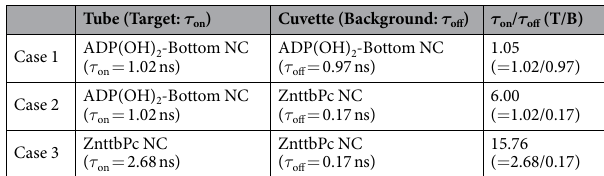
Table 1. NC: Nanocapsules. In Case 1, both the tube and the cuvette were filled with ADP(OH) 2 -Bottom encapsulated 5%-F98 pluronic nanocapsules. In Case 2, the tube was filled with ADP(OH) 2 -Bottom encapsulated 5%-F98 pluronic nanocapsules and the cuvette with ZnttbPc encapsulated 5%-F98 pluronic nanocapsules. In Case 3, both the tube and the cuvette were filled with ZnttbPc encapsulated 5%-F98 pluronic nanocapsules. For ADP(OH) 2 -Bottom based contrast agent: τ on = 1.02 ns and τ off = 0.97 ns. For ZnttbPc based contrast agent: τ on = 2.68 ns and τ off = 0.17